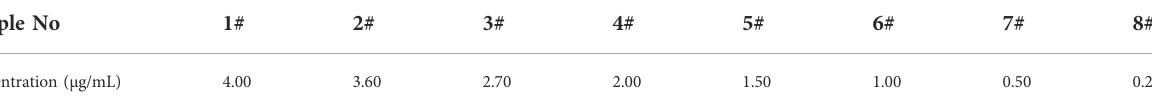
TABLE 1 Concentration of Na element in NaCl solution.